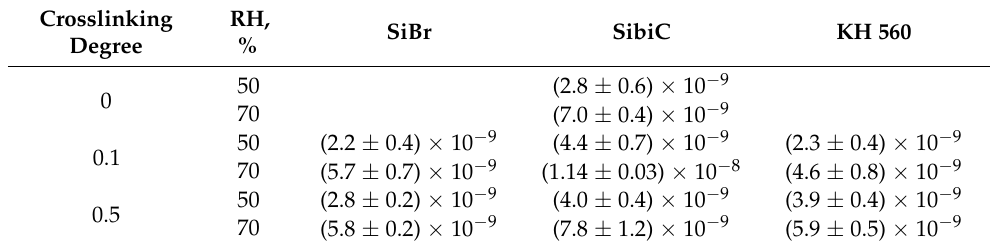
Table 4. Diffusion permeability (cm 2 s − 1 ) of hydrogen through PBI membranes crosslinked with different silanes.